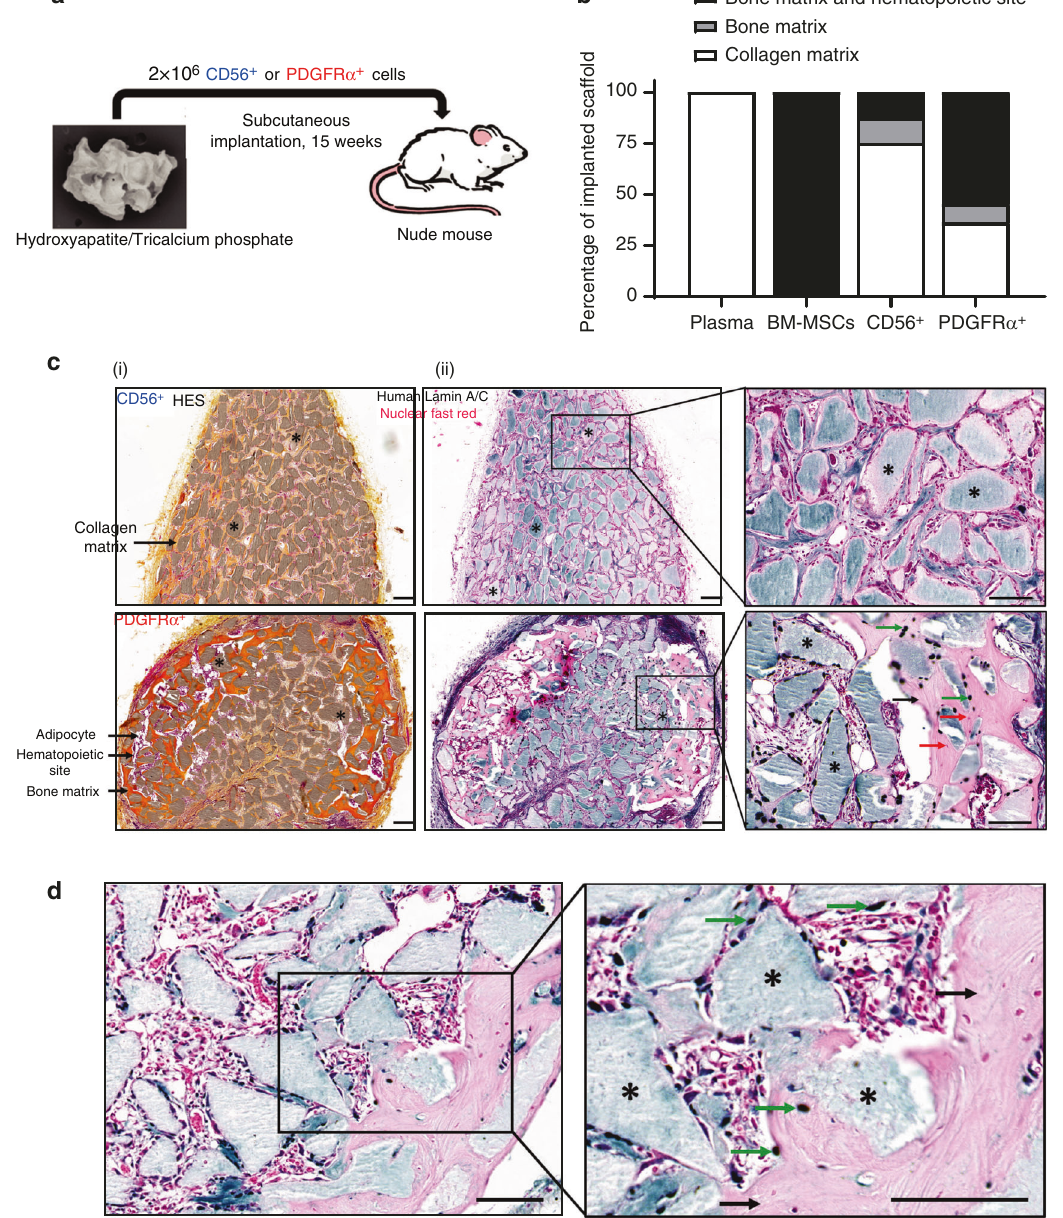
Fig. 7 Human PDGFR α + cells isolated from muscles surrounding NHO support in vivo bone formation. a Schematic representation of the in vivo osteogenic assay. Hydroxyapatite/calcium phosphate plasma scaffolds were seeded either with 2× 10 6 CD56 + cells, 2 ×10 6 PDGFR α + cells sorted from muscles surrounding NHOs, 2 ×10 6 human BM-MSCs or without cells ( “ plasma ” negative control) and subcutaneously implanted in the backs of nude mice for 15 weeks. b Percentage of scaffolds containing either collagen matrix alone, bone matrix alone, or bone matrix associated with hematopoietic colonization. Human plasma ( n = 4 donors), BM-MSCs ( n = 6 donors), CD56 + cells ( n = 8; 4 donors, 2 implants/donor) and PDGFR α + cells ( n = 11; 6 donors, 2 implants/donor for 5 donors and 1 implant for one donor). c(i ) Representative images of hematoxylin-eosin-safranin (HES) staining of CD56 + and PDGFR α + cell-seeded implant sections. Nuclei are stained purple, cell cytoplasm is stained pink, and collagen fi bers are stained orange. * ː hydroxyapatite. Magni fi cation 10X; scale bar = 100µm. c ( ii ) Speci fi c human Lamin A/C staining of representative CD56 + and PDGFR α + cell-seeded implant sections. *: hydroxyapatite scaffold; black arrows: bone matrix; green arrow: human osteocytes; red arrows: mouse osteocytes. Magni fi cation ×10 and ×20; scale bar = 100 µm. d Osterix/SP7 staining of a representative PDGFR α + cell-seeded implant section. *: hydroxyapatite scaffold; black arrows: bone matrix; green arrows: osterix + osteoblasts. Magni fi cation ×20 and ×40; scale bar = form ectopic bones with hematopoietic marrow when implanted progenitor cells that shared the same antigenic pro fi le as muscle in mice. Although it remains unclear whether this was caused by FAPs. Likewise, over half of PDGFR α + mesenchymal progenitors contaminating mesenchymal cells in the sorted population, our sorted from the muscles surrounding NHOs from SCI patients results suggest that in both mice and humans, NHOs are derived effectively formed ectopic bones when transplanted into from mesenchymal progenitor cells and not from myogenic permissive immunode fi cient mice. One of 8 preparations of progenitor cells such as SCs. CD56 + muscle progenitor cells from these NHO biopsies could